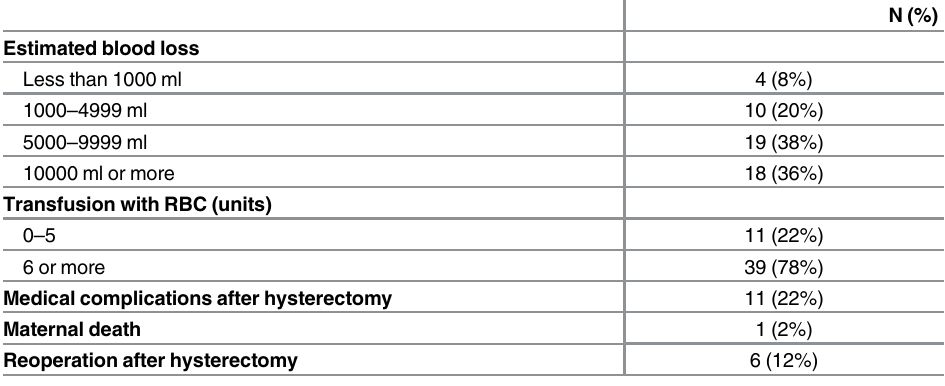
Table 4. Obstetric complications related to peripartum